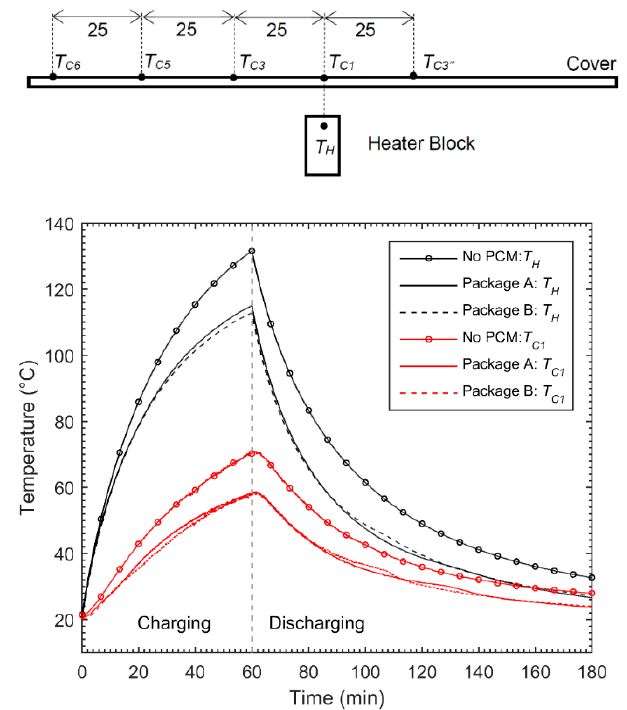
Figure 6. Temperature profile of the heater ( T H ) and the cover surface ( T C1 ) for the experiment with no PCM package, package A, and package B with a constant power input of 5 W for 60 min.